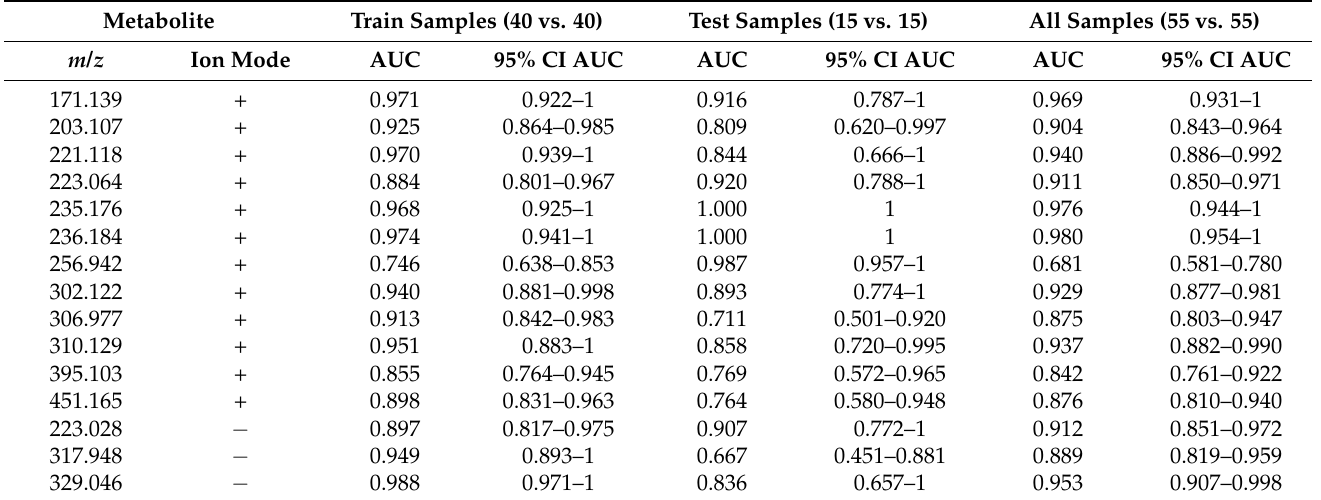
Table 4. Multivariate analysis (LASSO & SVM-RFE) on training, test, and all samples. Metabolite Train Samples (40 vs.